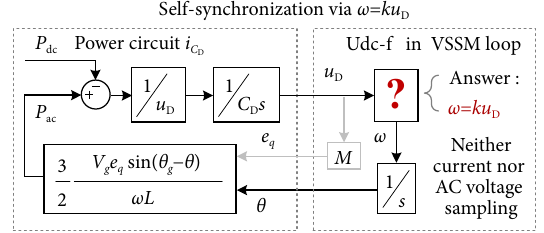
Fig. 4 Self-synchronization principle of the VSSM mechanism.